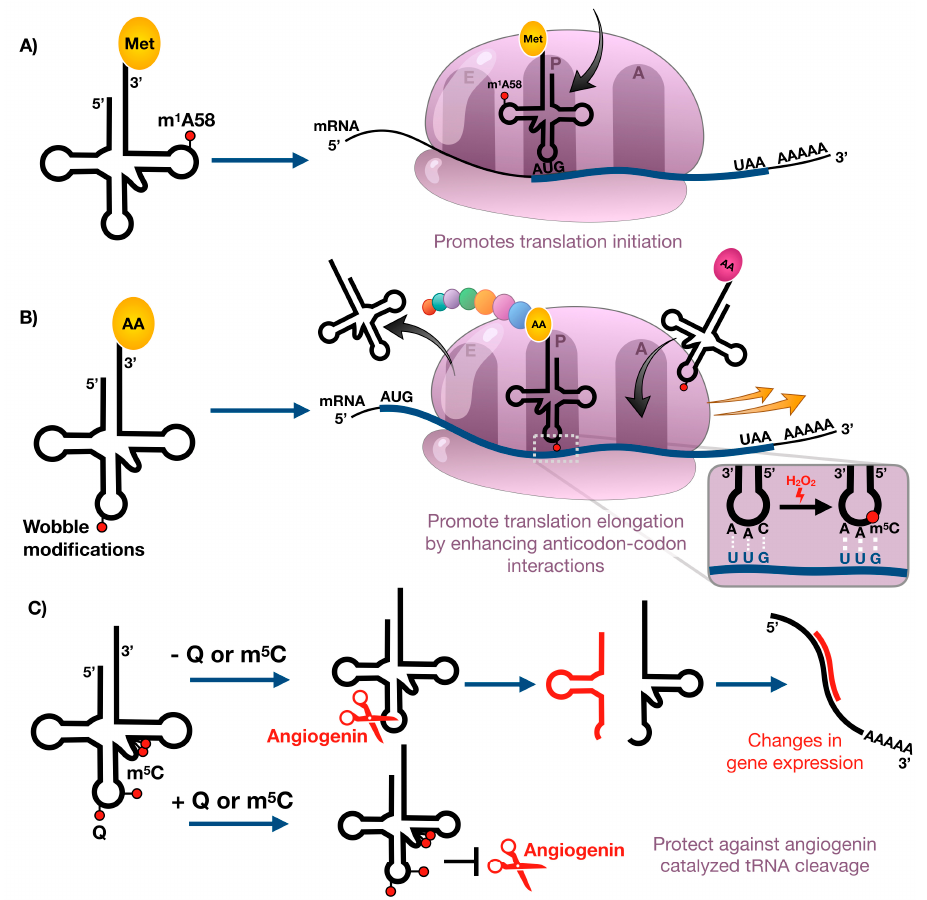
Figure 3. Stress-induced changes in tRNA modification levels can regulate ( A ) translation initiation, ( B ) translation elongation, and ( C ) tRNA cleavage.